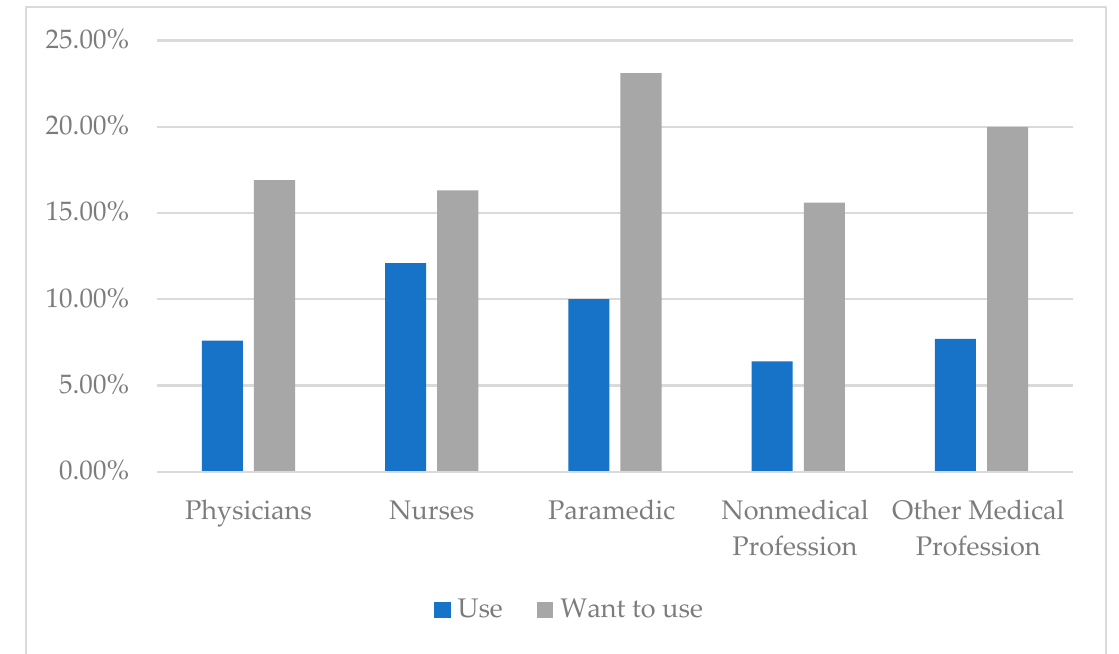
Figure 2. Percent distribution of respondents willing to use help or receiving help by profession (N = 2196).